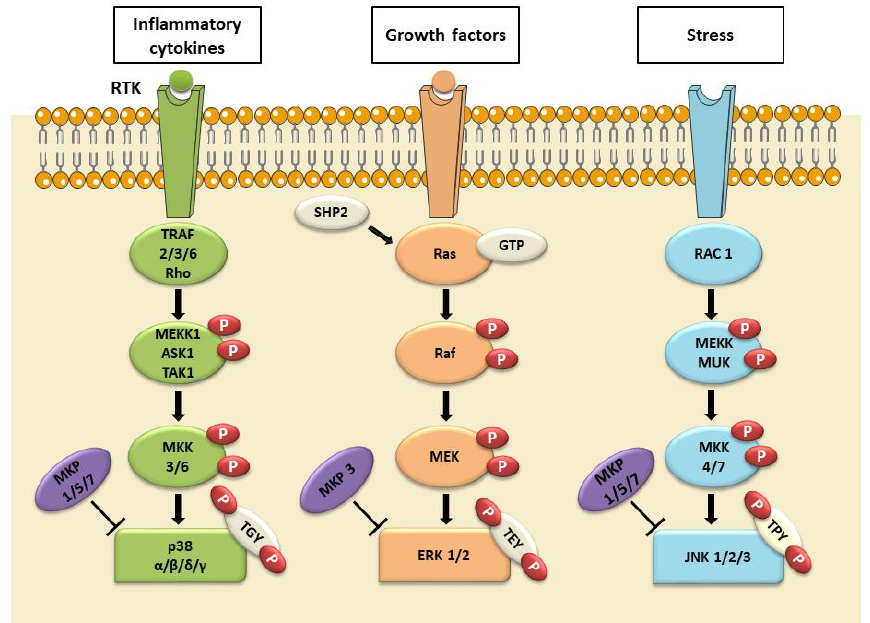
Figure 2. The MAPK signaling pathways. In mammalian cells, there are three well-known MAPK pathways: the ERK1/2, the c-JUN N-terminal kinase 1, 2, and 3 (JNK1/2/3), and the p38 α , β , δ , and γ MAPK pathways. ERK1/2 is activated in response to growth factors, hormones, and proinflammatory stimuli, while JNK1/2/3 and p38 α , β , δ , and γ are activated by cellular and environmental stresses, in addition to pro-inflammatory stimuli. The image was created using the image bank of Servier Medical Art (Available online: http://smart.servier.com/, accessed on